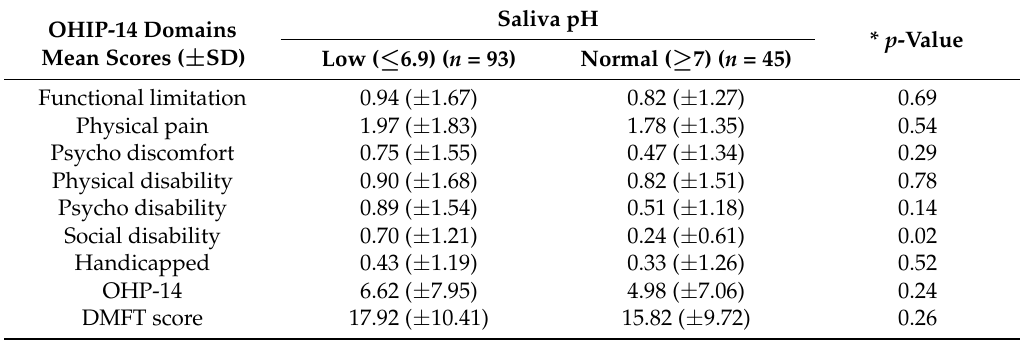
Table 7. Association between mean OHIP-14 scores, caries status and saliva pH ( N =